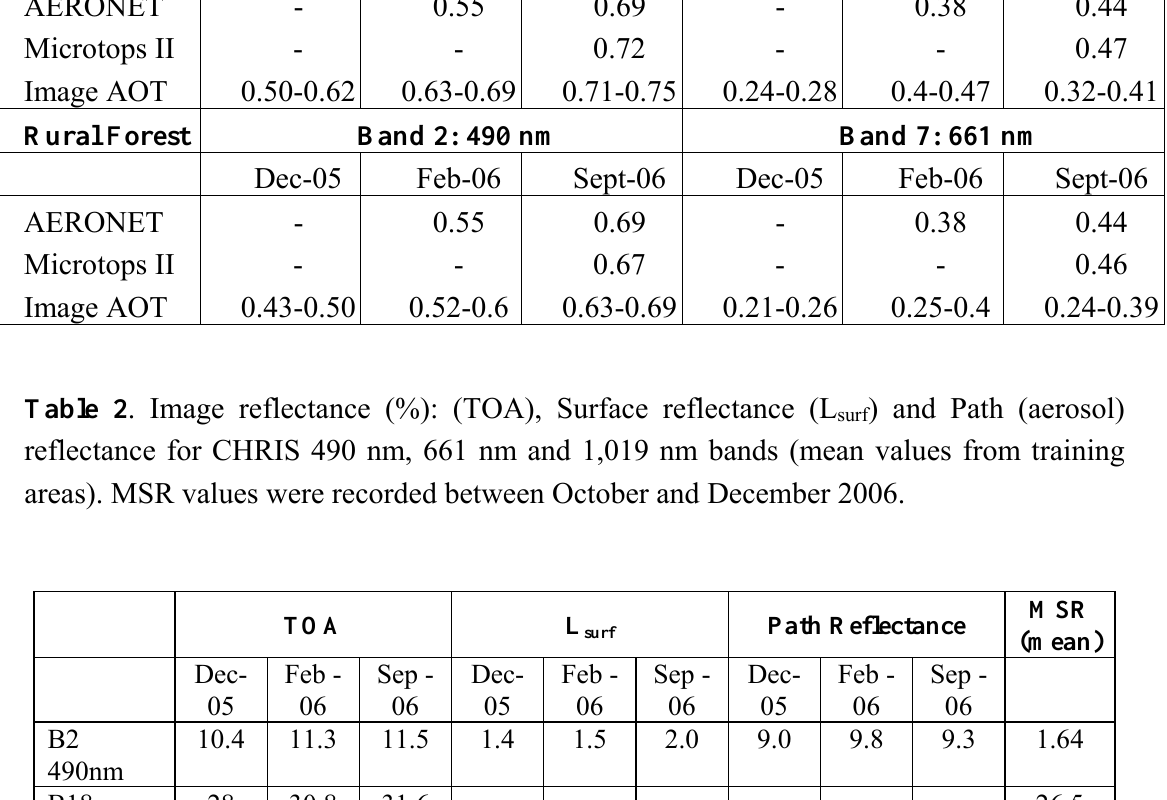
Table 1 . AOT values from AERONET, Microtops II, and range of image AOT values for urban and rural training areas. Range represents 1 s.d.